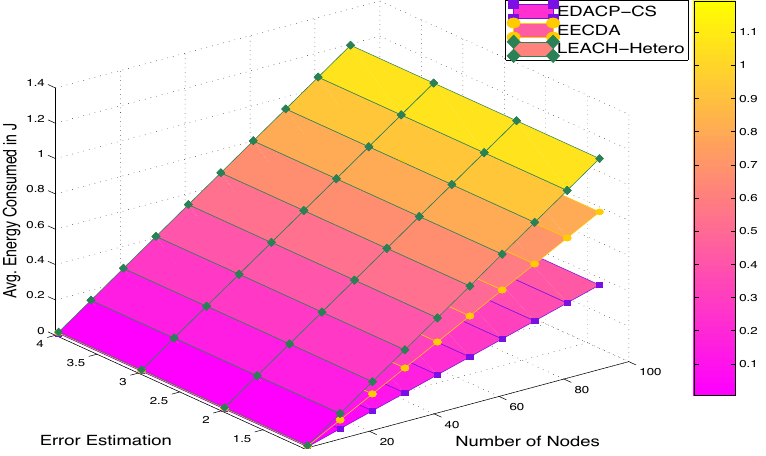
Figure 6. Average energy consumption during error occurrence in ECADP-CS, energy efficient clustering and data aggregation (EECDA), and Low-Energy Adaptive Clustering Hierarchy (LEACH)-Hetero